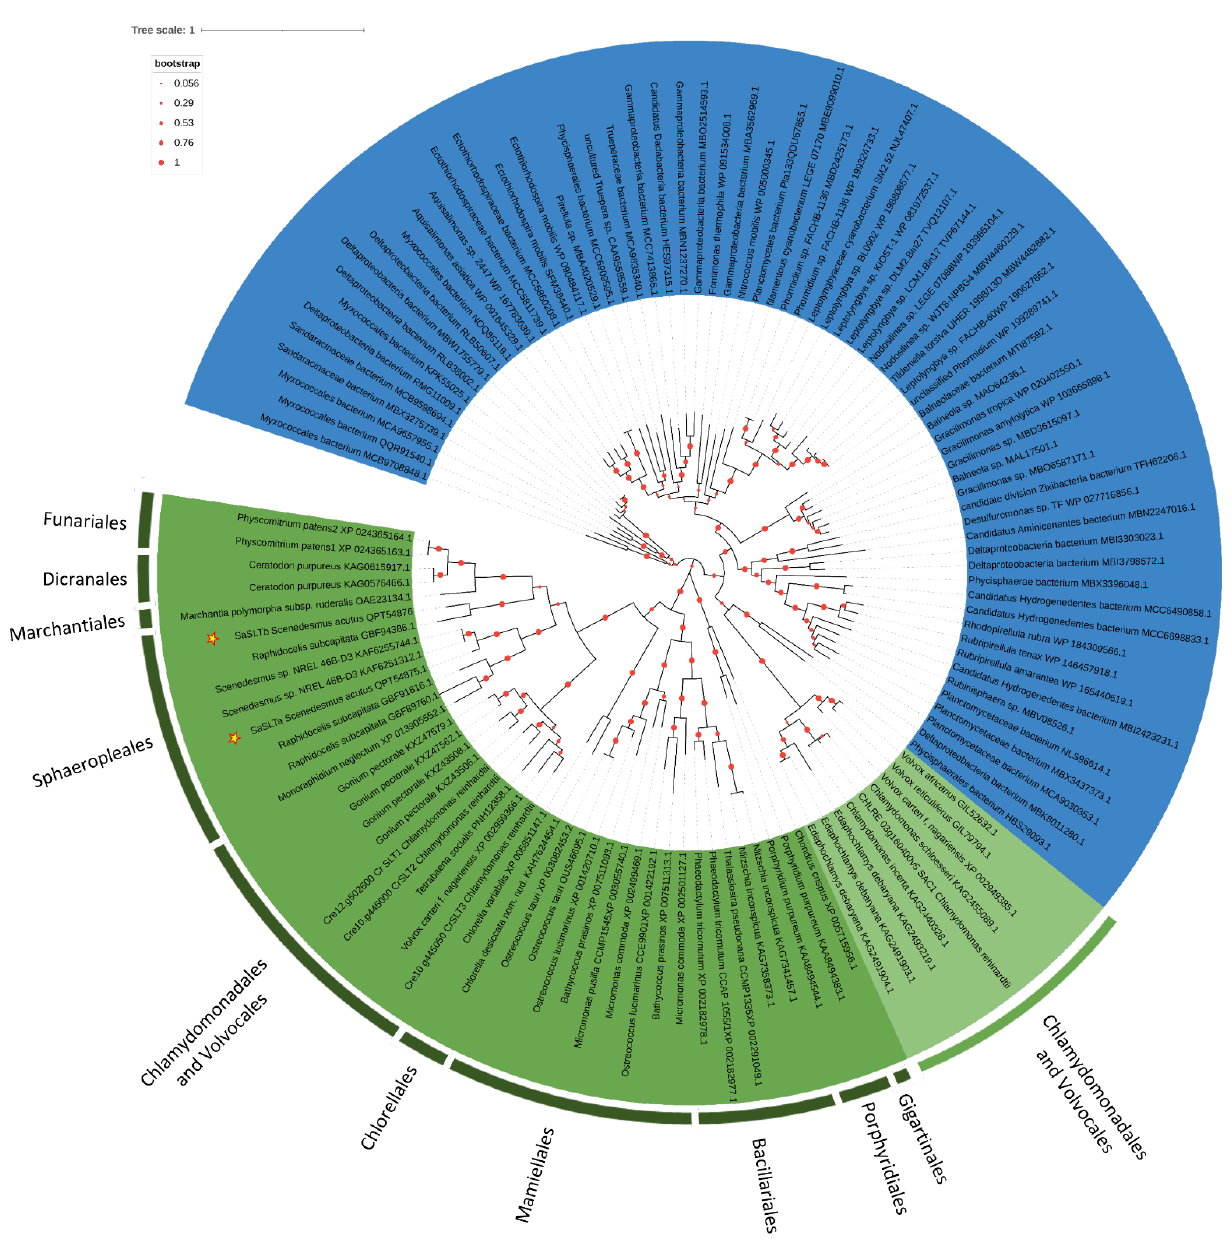
Figure 6. The evolutionary history of SLTs. The tree with the highest log likelihood ( − 88,409.27) is shown. The percentage of trees in which the associated taxa clustered together is shown below the branches. The tree is drawn to scale, with branch lengths measured in the number of substitutions per site. This analysis involved 117 amino acid sequences (Table S1) for a total of 1769 positions in the final dataset.